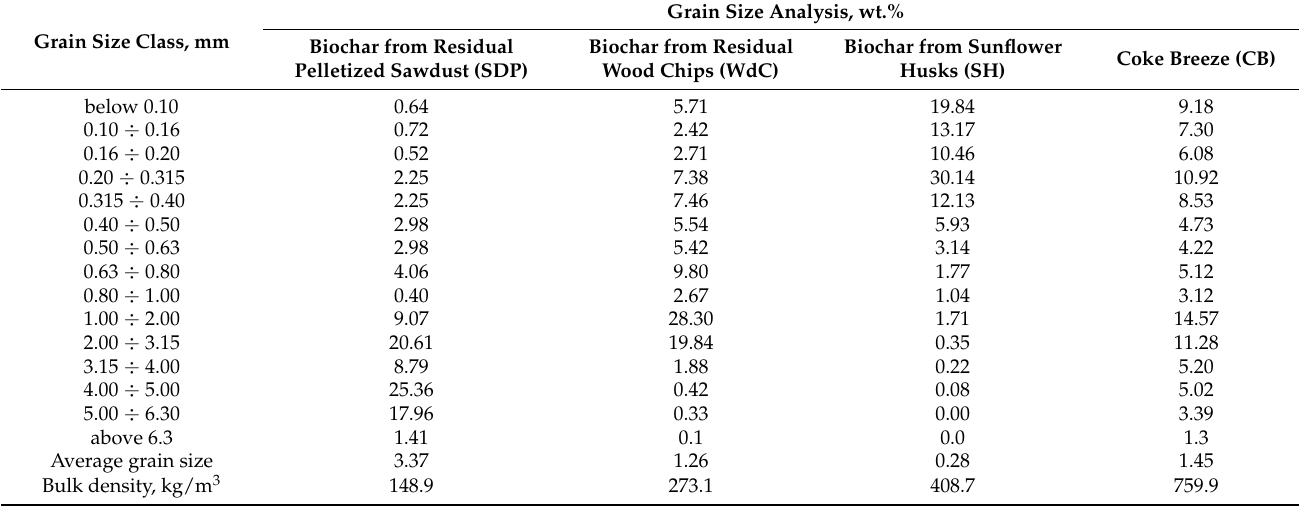
Grain Size Class,